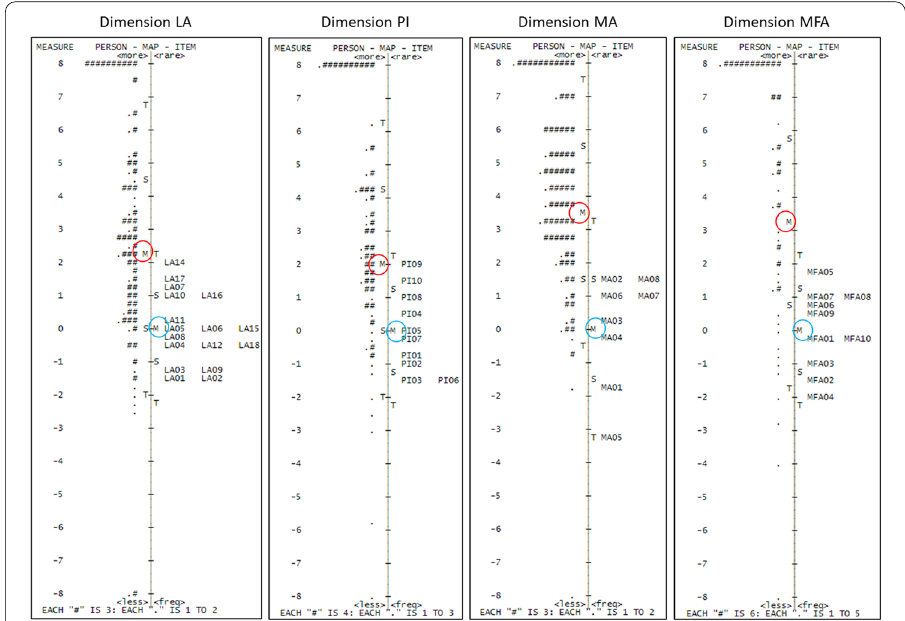
Fig. 2 Wright map for the final model for the four dimensions. Note : The figure is an output of the software Winsteps table 1.2: circled on the left side the average attitudes of persons and on the right side the average difficulties of the